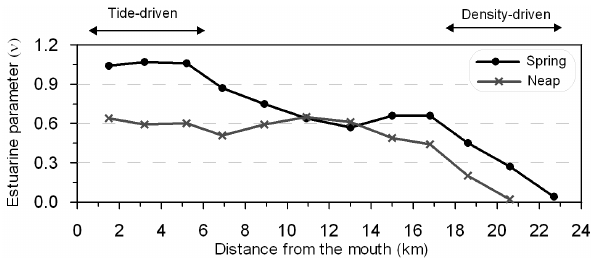
Fig. 12. Spatial variation in the potential energy anomaly during spring and neap tides along the Sumjin River Estuary. Each con- tour is the average of twelve samples obtained from August 2004 to April